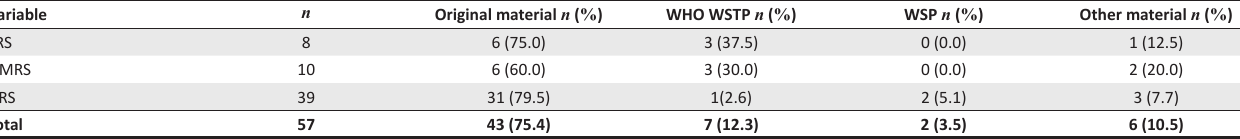
TABLE 2: Frequency of wheelchair service content taught by resource settings.